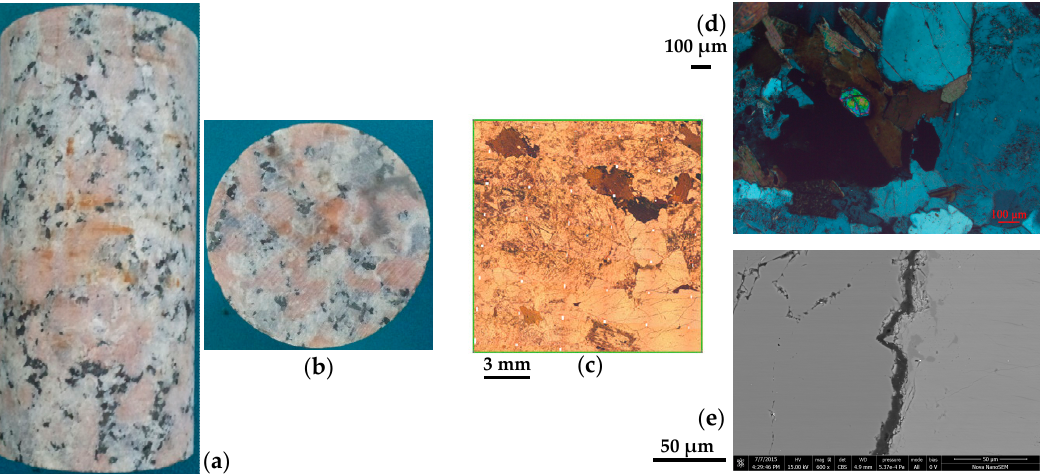
Figure 1. ( a , b ) Typical NRG01 granite samples (height: 100 mm; diameter: 50 mm) [50] and ( c – e ) observations of micro-cracks in NRG01 granite samples [51] (with copyright permission from